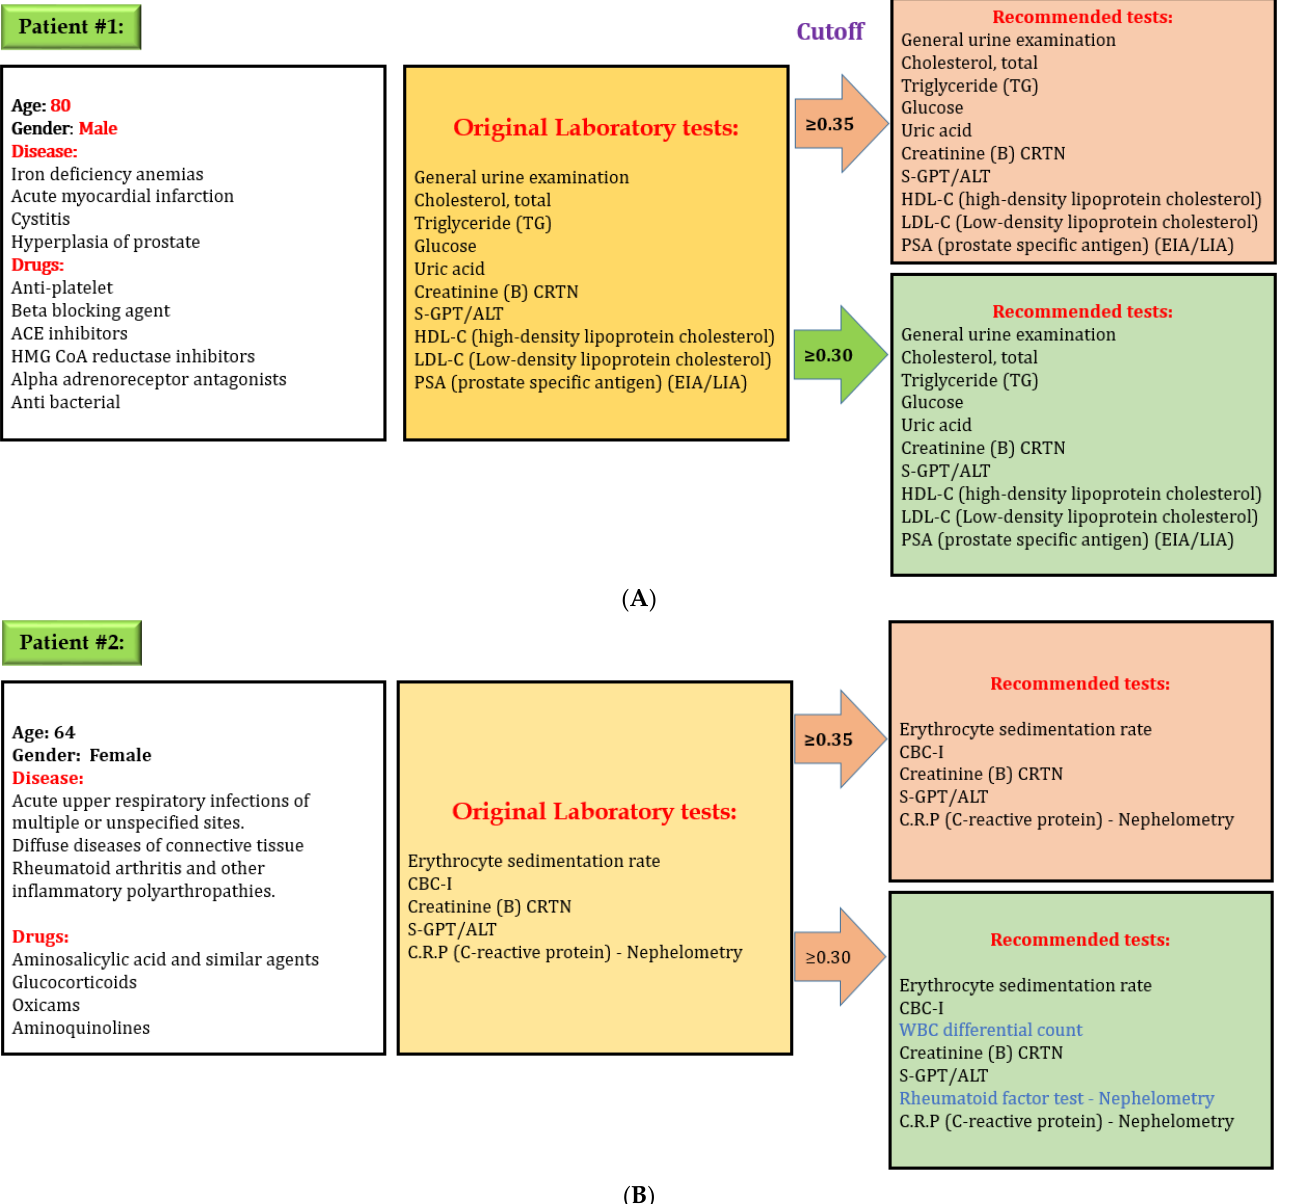
Figure 8. Evaluation of the performance of the deep learning model for predicting laboratory tests, ( A ) system always give exact recommendation for laboratory tests with a cut off value 0.35, ( B ) system might give extra recommendation of laboratory tests with a cut off value 0.30; however all laboratory recommendations are correct. Physicians can adjust cut-off value if additional tests are required. Decreasing cut-off value will increase the number of laboratory tests recommendation.